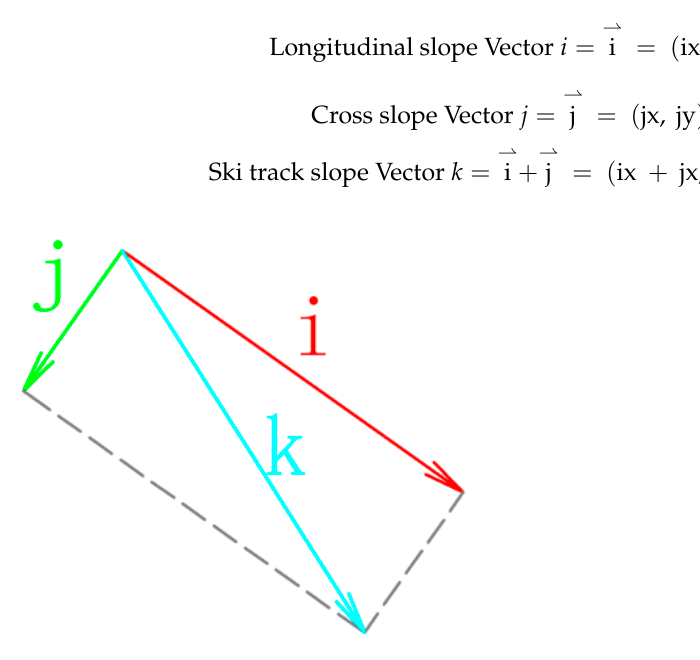
Figure 9. Increasing the cross slope for the ski track.